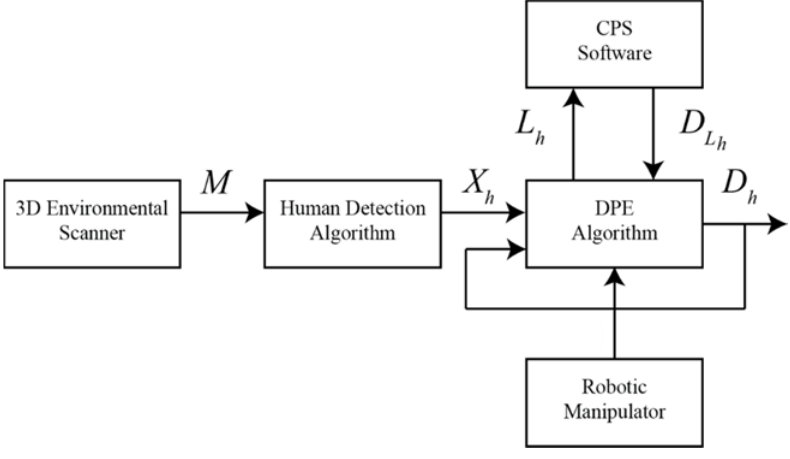
Figure 1. Software architecture diagram and data flow schematics.